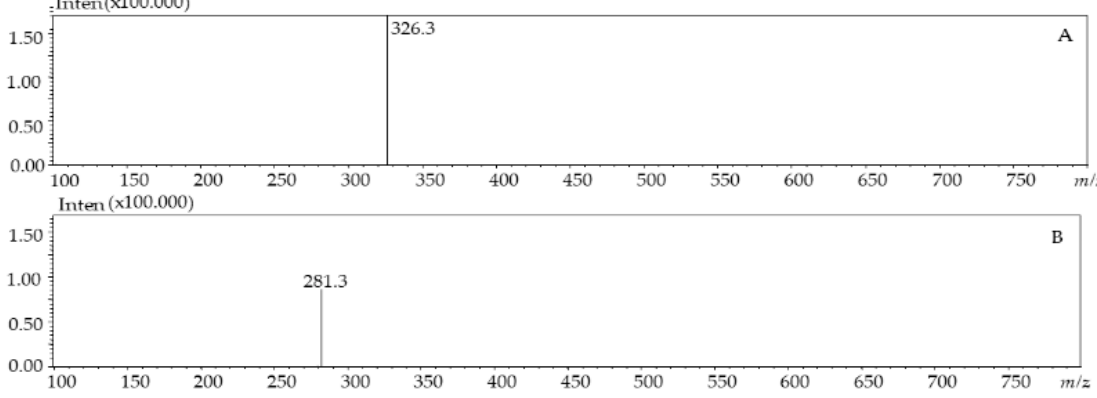
Figure 1. Chromatograms, obtained by HPLC–PDA–MS, of the polyphenolic compounds from four species of microalgae: ( A ) Phaeodactylum tricornutum , ( B ) Nannochloris sp, ( C ) Tetraselmis suecica , and ( D ) Nannochloropsis gaditana . Chromatographic conditions: See text. Peak identification is given in Table 3 ( λ =280 nm).